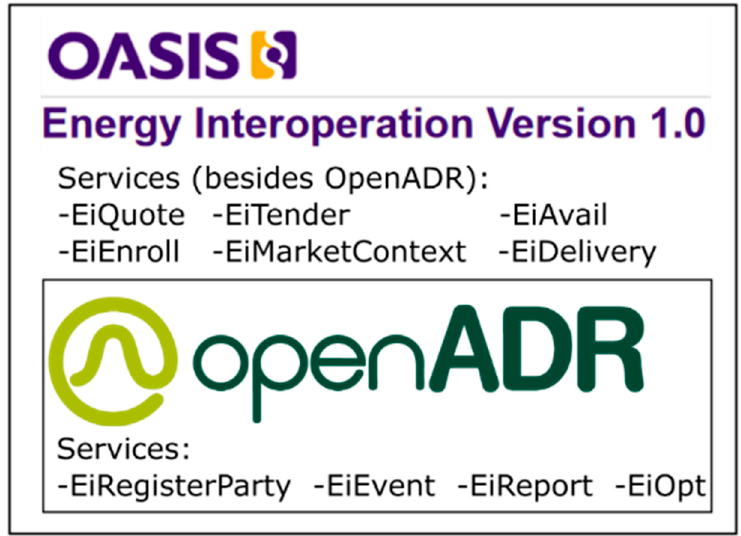
Figure 1. Open Automated Demand Response (OpenADR) Services vs. EI v1.0 Services.